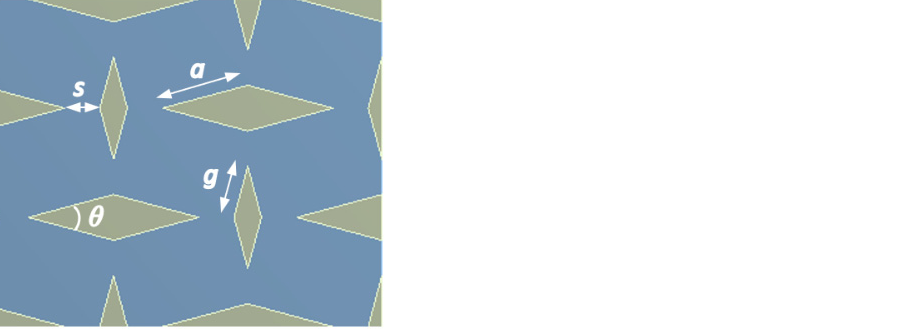
Figure 6. Geometric design parameters of the cellular structure with diamond shape inclusions.